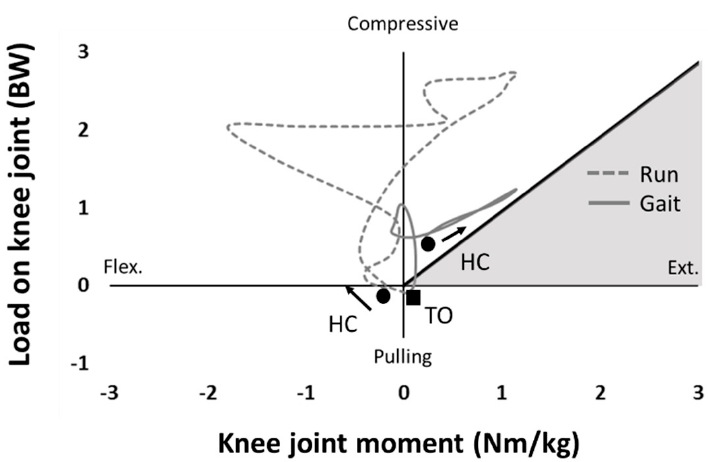
Figure 4. The load on the knee joint required for the stopper to remain at rest on the gear when the flexion moment acts around the knee joint axis. The load was normalized with body weight (BW). Positive moments indicate knee extension moment (Ext.). Positive forces indicate compressive force. ● is the heel contact, and ■ is the toe off.